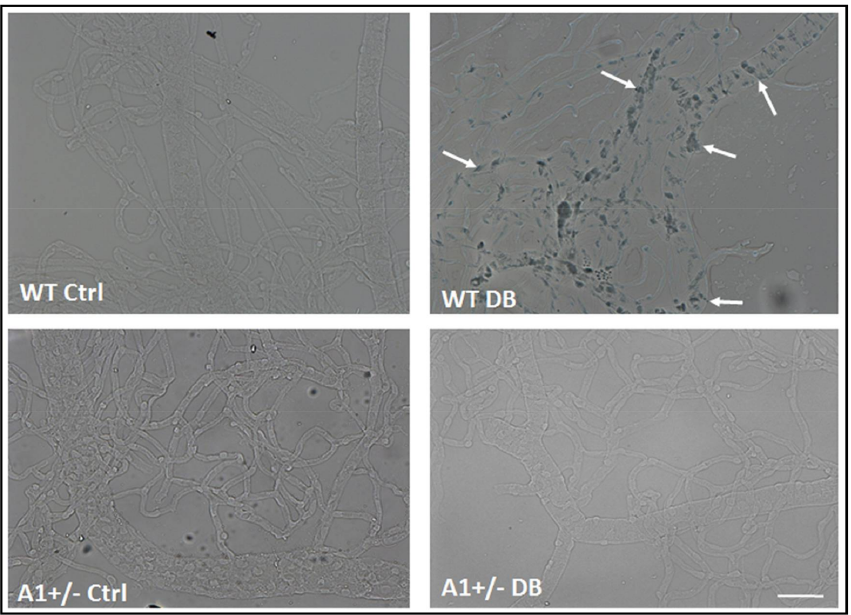
Figure 6. A1 deletion prevents diabetes-induced senescence in retinal vessels. SA β -Gal activity images of isolated retinal vessels showing increased activity (arrows) in vessels isolated from WT diabetic mice. The vessels isolated from A1+/ − diabetic retinas are negative for SA β -Gal staining. The non-diabetic control retinas from both WT and A1+/ − mice are also negative for SA β -Gal staining. n = 3–5. Scale bar = 50 µ